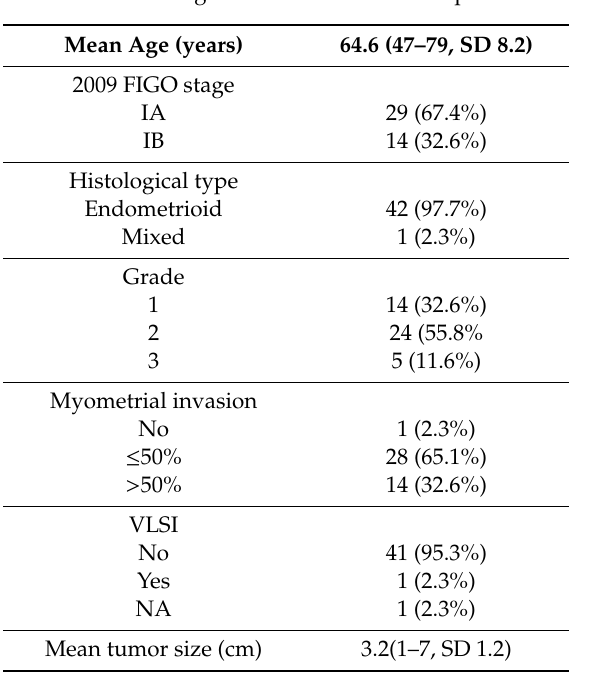
Table 3. Pathological characteristics of the